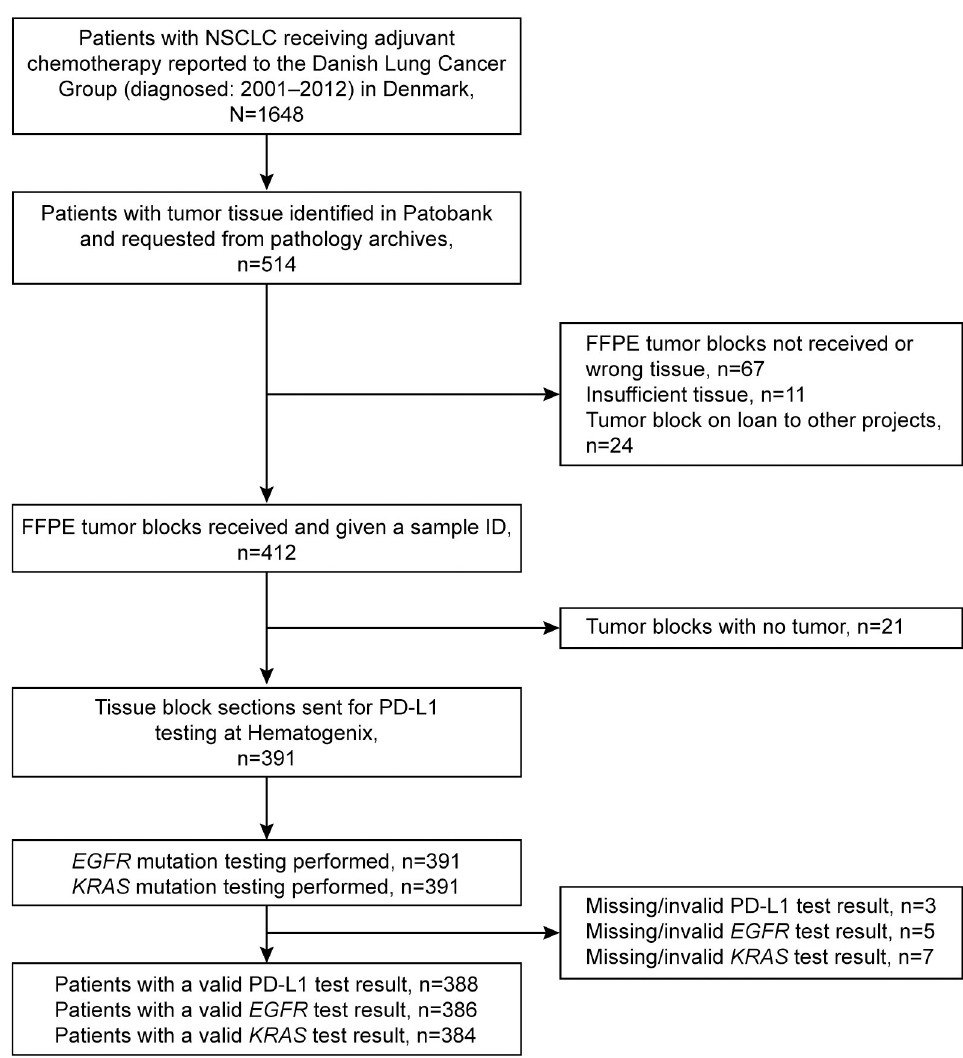
Fig 1. Patient disposition. EGFR, epidermal growth factor receptor; FFPE, formalin-fixed, paraffin-embedded; KRAS, V-Ki-Ras2 Kirsten rat sarcoma; NSCLC, non-small cell lung cancer; PD-L1, programmed cell death ligand-1.